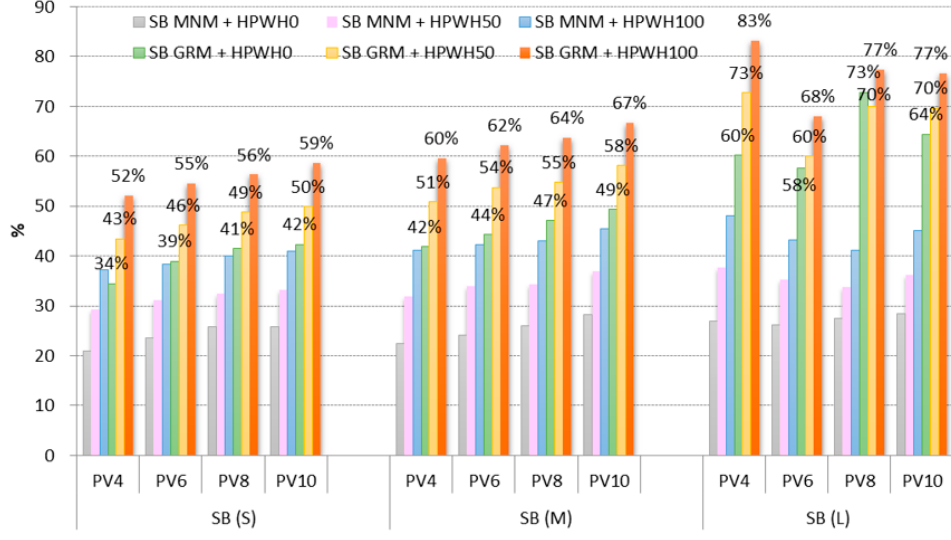
Figure 18. Annual SSR of SB and HPWH.